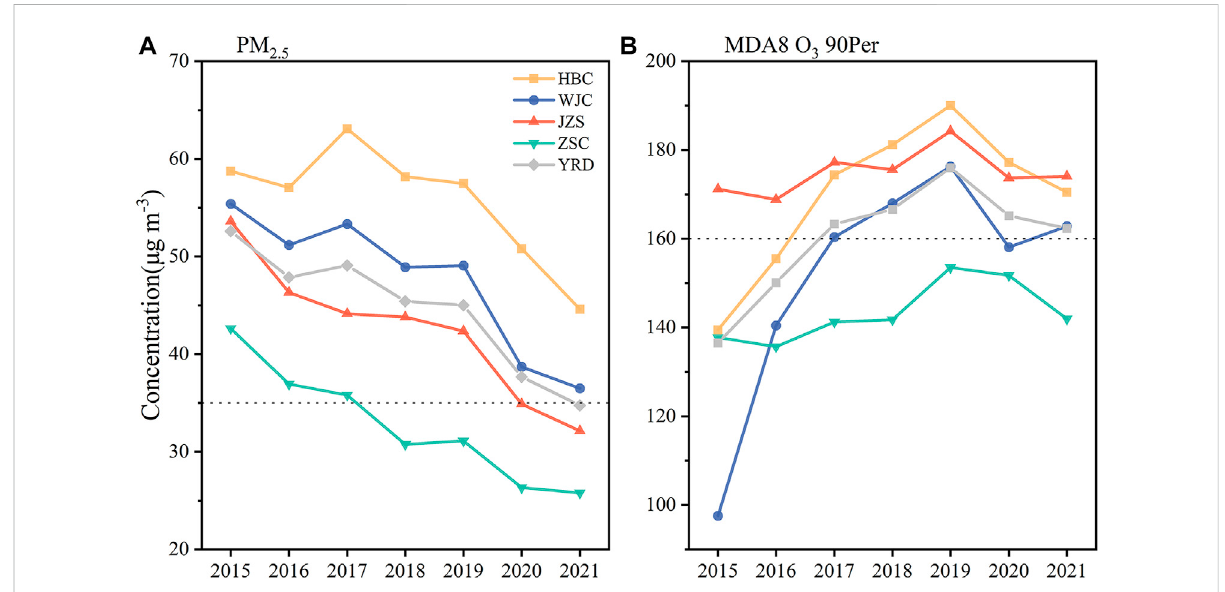
FIGURE 2 Inter-annualvariations of (A) meanPM 2.5 and (B) MDA8O 3 90Perinfour cityclustersand theYRDduring 2015 – 2021.Black dottedlinesdenote the Class II of air quality standards